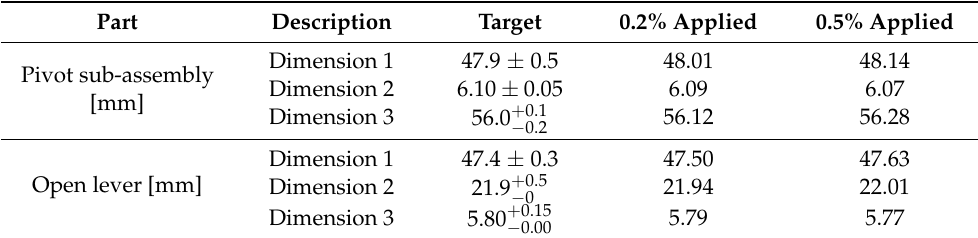
Table 11. Key dimensions with material shrinkage.